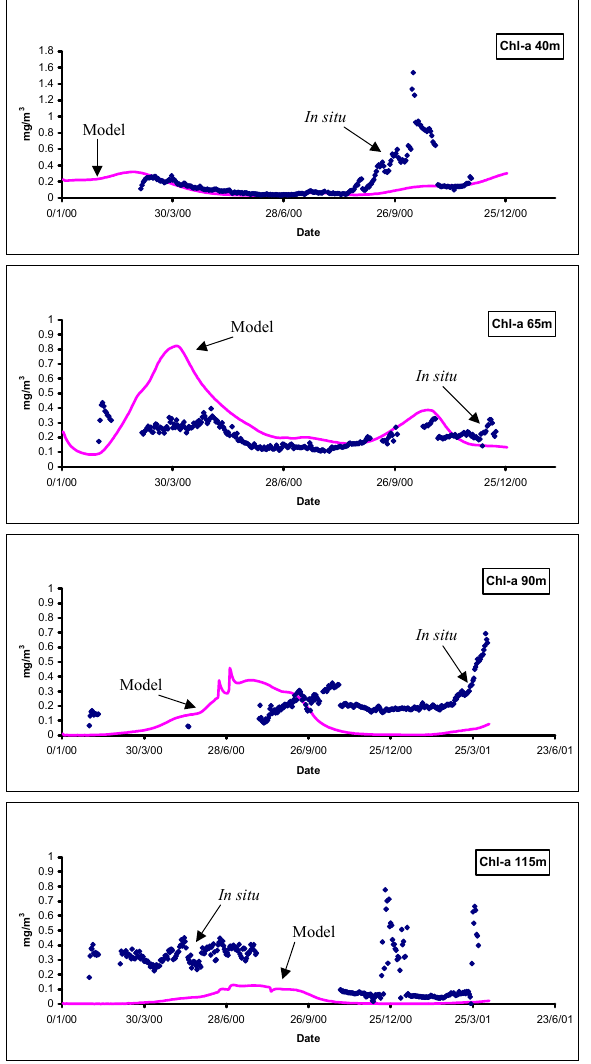
Fig. 5. Validation of model chlorophyll concentration with CTD measurements at 40, 65, 90 and 115m.